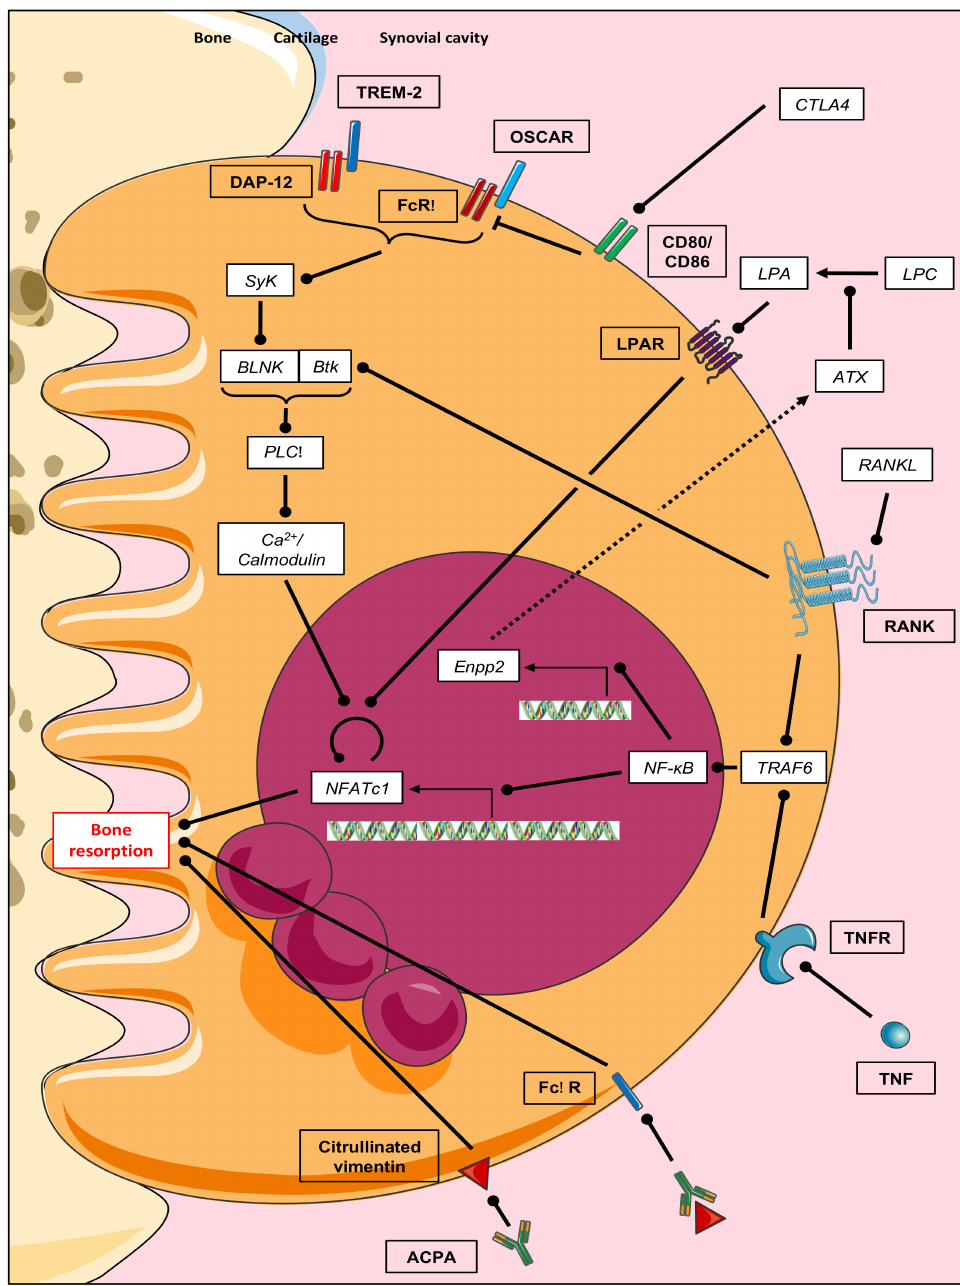
Figure 3. Enhanced osteoclast bone resorption in rheumatoid arthritis. Bone resorption is mediated by multiple path- ways (RANKL/RANK, inflammatory cytokines, ITAM/Ca 2+ , and ATX/LPA) converging on NFATc1. Additionally, bone loss is mediated by direct and indirect ACPA-related mechanisms. ACPA: Anti-citrullinated peptide antibod- ies; ATX: Autotaxin; BLNK: B-cell linker protein; BtK: Burton tyrosine kinase; CD: Cluster of differentiation; CTLA4: Cytotoxic T-lymphocyte-associated protein 4; DAP-12: DNAX-activating protein of 12 kDa; Enpp2: Ectonucleotid py- rophosphatase/phosphodiesterase 2; Fc γ R: Fc gamma receptor; FcR γ : Fc receptor gamma subunit; IgG: Immunoglobulin G; IL: Interleukine; LPA: Lysophosphatidic acid; LPAR: LPA receptor; LPC: Lysophosphatidylcholine; MHC-1: Major histocompatibility complex 1; NFATc1: Nuclear factor of activated T-cells cytoplasmic 1; NF- κ b: Nuclear factor kappa B; OSCAR: Osteoclast associated receptor; PLC γ : Phospholipase C gamma; RANK: Receptor activator of nuclear factor kappa B; RANKL: RANK ligand; Syk: Spleen tyrosine kinase; TNF: Tumor necrosis factor; TRAF6: TNF receptor-associated factor 6; TREM-2: Triggering receptor expressed on myeloid cell. 2. Dashed triangle arrowheads: Secretion; simple triangle arrowheads: Chemical reaction; round arrowheads: Activation; flat arrowheads: